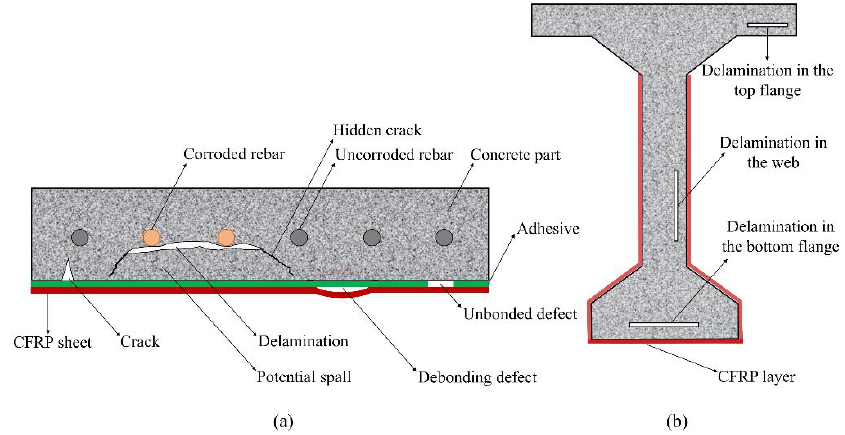
Figure 1. Deteriorations forming in concrete structures strengthened with one carbon fiber-reinforced polymer (CFRP) layer: ( a ) common types of defects; ( b ) delamination in T-shaped